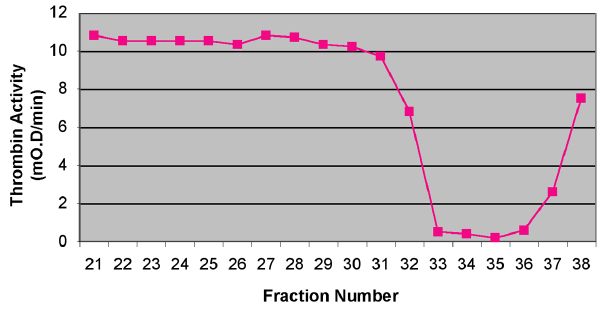
Figure 2. Thrombin inhibitory activity in size exclusion chromatography fractions. Anion-exchange fractionate proteins were fractionated on a Superdex S200 column as described in Materials and Methods. Each enzymatic assay included 7.5 m l of the indicated column fraction.